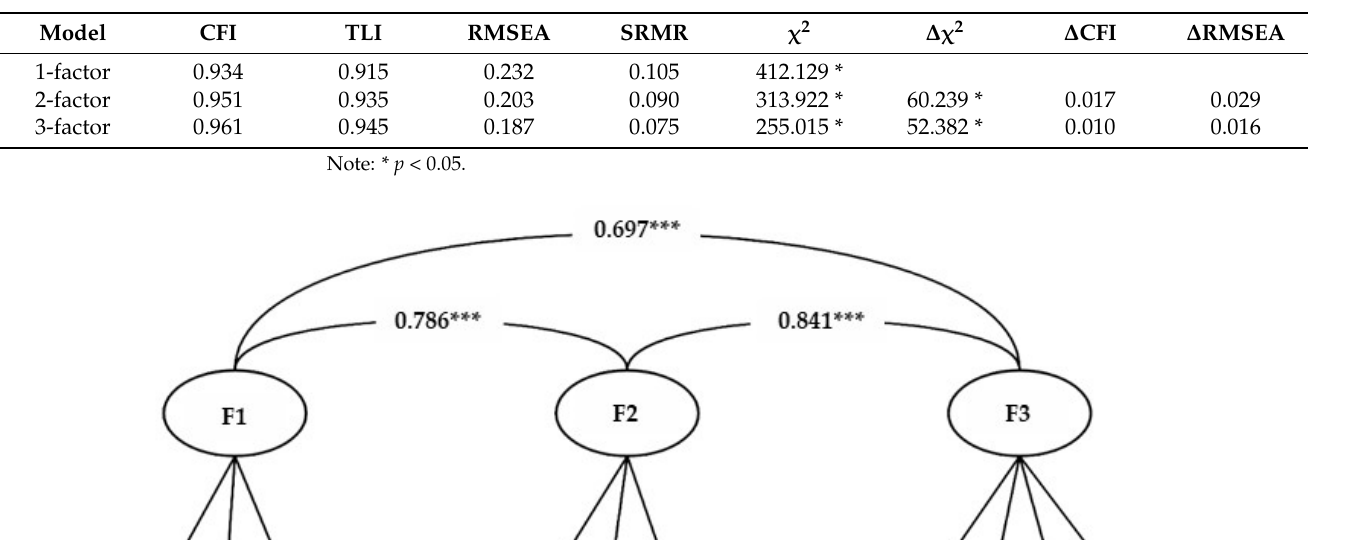
Table 1. Fit indices for the three evaluated models.